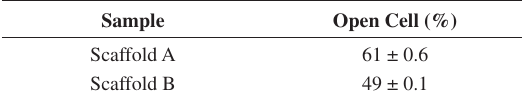
Table 2. Results of pycnometer analysis.